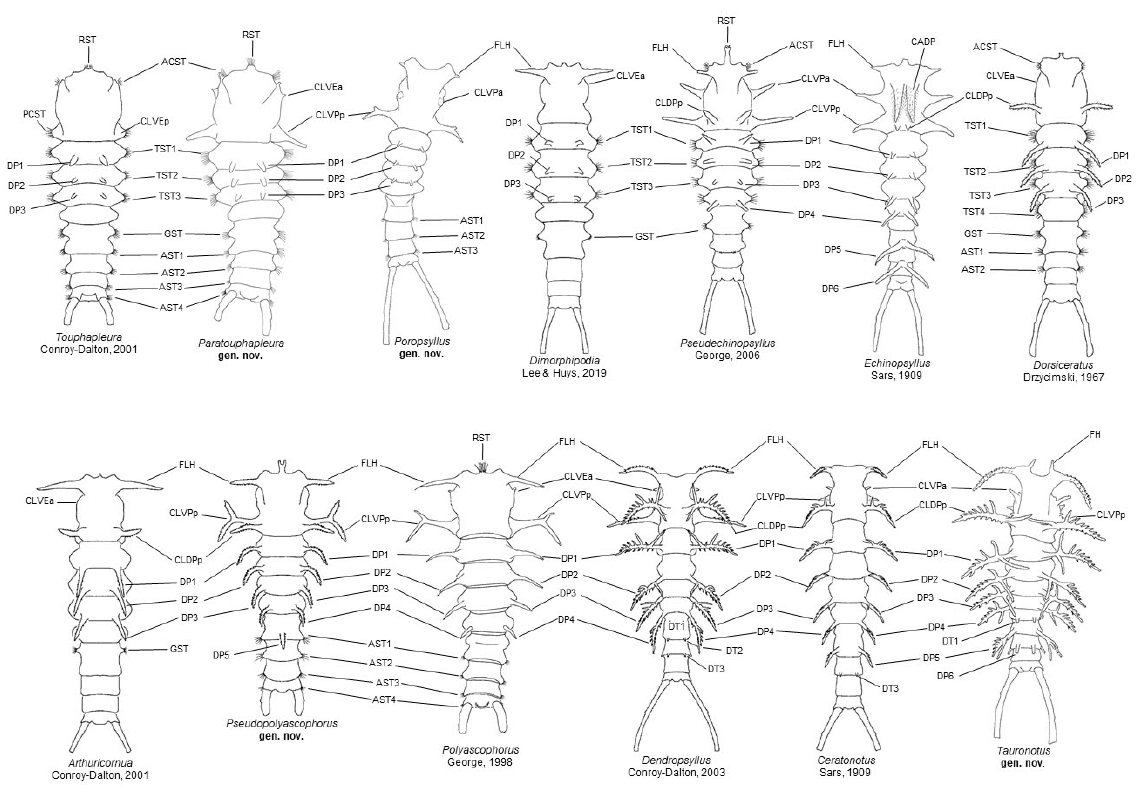
Fig. 15. Schematic illustrations of the 13 genera assigned to the Ceratonotus group, indicating the positions of the cuticular processes, socles, and setular tufts, amended from Lee & Huys (2019). Abbreviations according to the abbreviations list in the